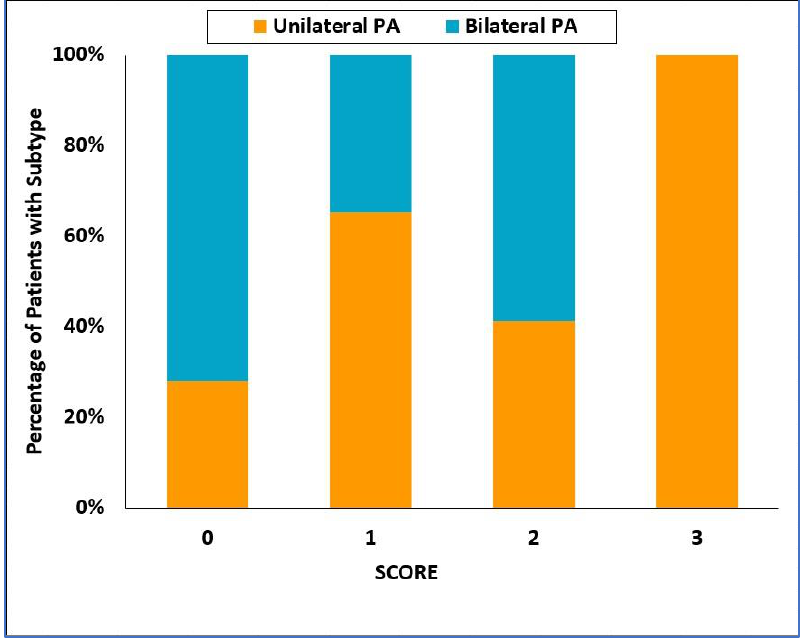
Figure 6. Categorized histogram of the SCORE for unilateral and bilateral primary aldosteronism. PA — primary aldosteronism.